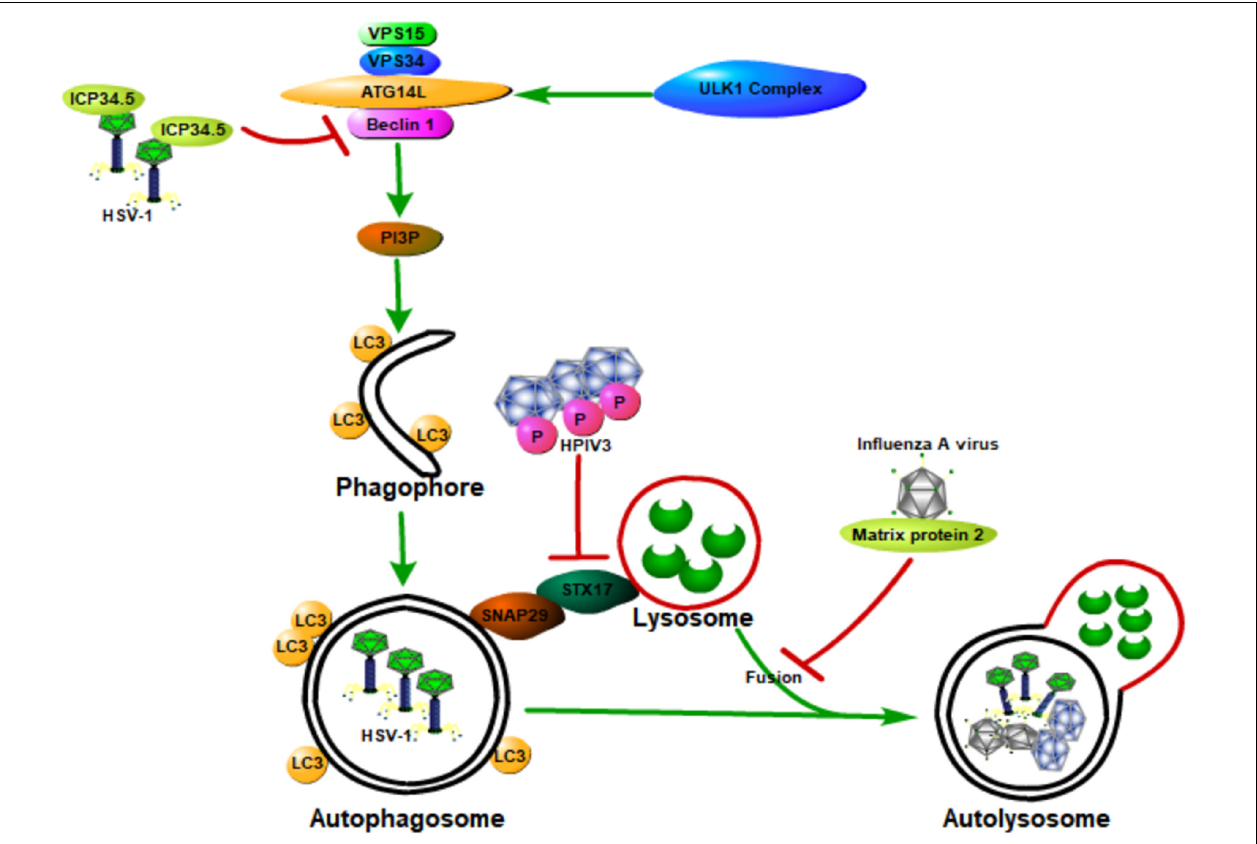
FIGURE 4 | Viruses hijack and subvert host autophagy to aid their own infections and pathogenesis. Some viruses have developed various strategies to hijack and subvert host autophagy to aid their own infections and pathogenesis. These strategies include (1) directly inhibiting autophagy activation through blocking the function of host ATG proteins; (2) inhibiting autophagy downstream degradation pathway; and (3) subverting host autophagy to benefit viral replication. Class III PI3K complex I (PI3KC3-C1), which can produce PI3P, is necessary for the nucleation of autophagosomes and is composed of VPS34, VPS15, Beclin 1, and ATG14L. ICP34.5 expressed by the HSV-1 could inhibit host autophagy activation through binding with the host autophagy protein Beclin 1. The matrix protein 2 of influenza A virus could inhibit autophagy function by blocking the autophagosome–lysosome fusion, causing the enhanced virus-induced cell death of infected cells and elevated viral antigen release. The human parainfluenza virus type 3 (HPIV3) phosphoprotein (P) binds to SNAP29, blocking its binding to syntaxin 17, therefore inhibiting the fusion of autophagosome-lysosome mediated by these two host SNARE proteins. All of these will contribute to the viral infection and